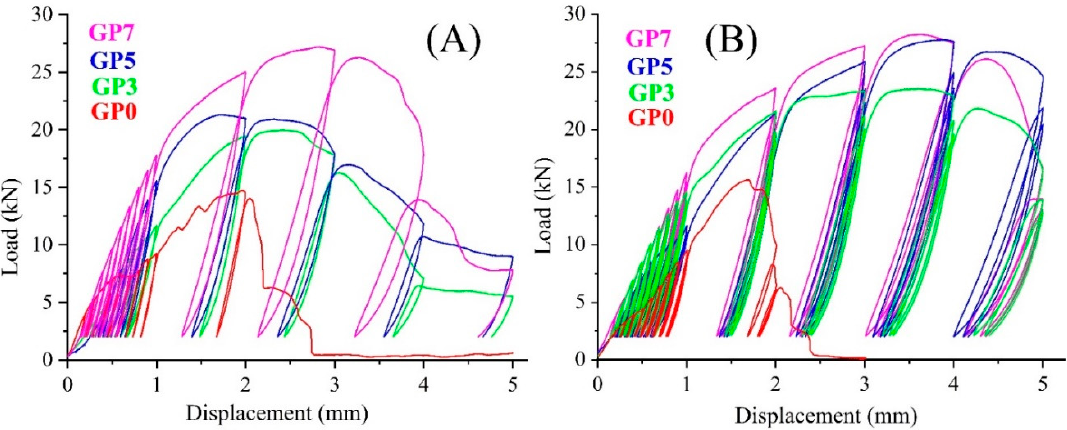
Figure 5. Uniaxial cyclic compression: ( A ) Single unloading/reloading cycle ( B ) three unloading/reloading cycles.